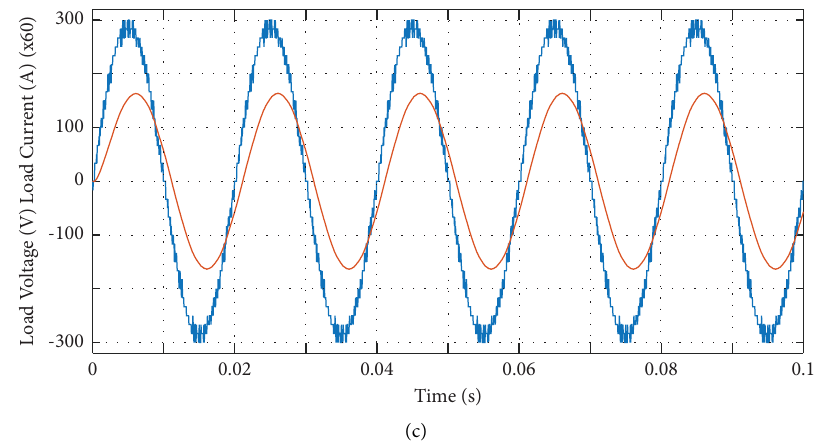
Figure 12: 11L CHB inverter load voltage and current at M � 1.0. (a) SPWM. (b) THIPWM. (c)